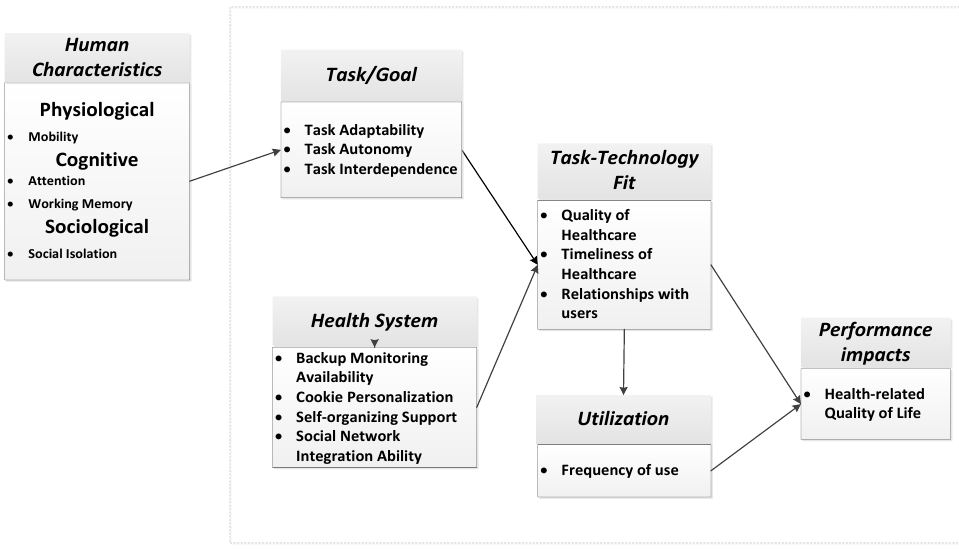
Figure 1: A conceptual framework for design IS to improve senior people’s